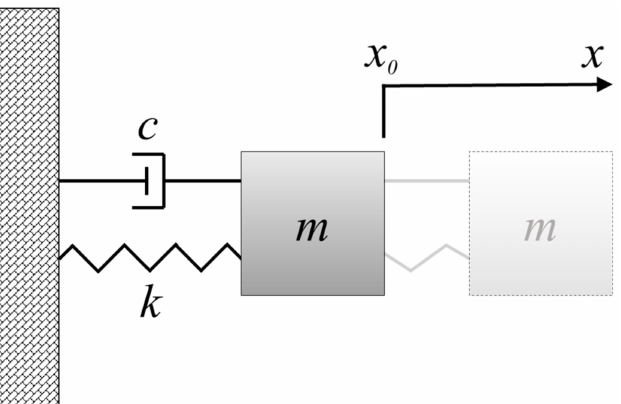
Figure 1. Mass–spring–damper system for simulation. Symbols m , k , and c indicate the values of the mass, spring, and damper, respectively.